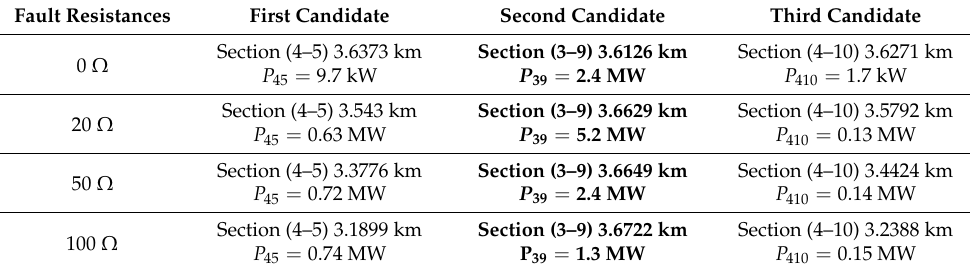
Table 2. Proposed Method Effectiveness under Different Fault